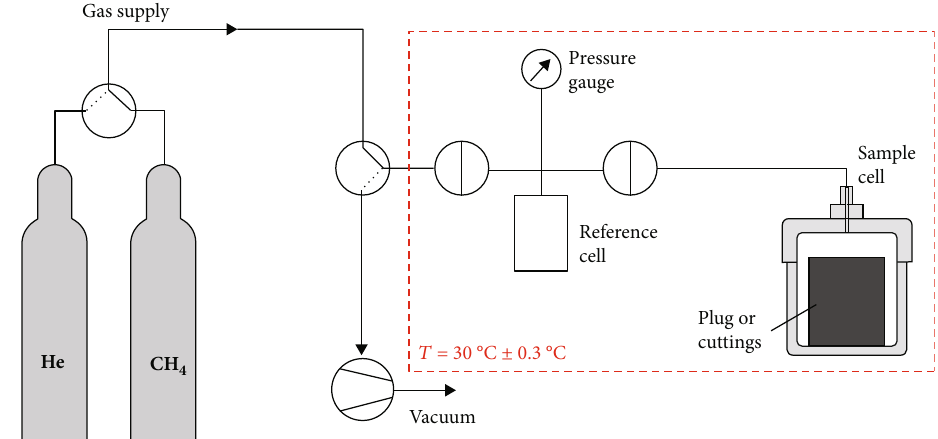
Figure 2: Schematic diagram of the experimental